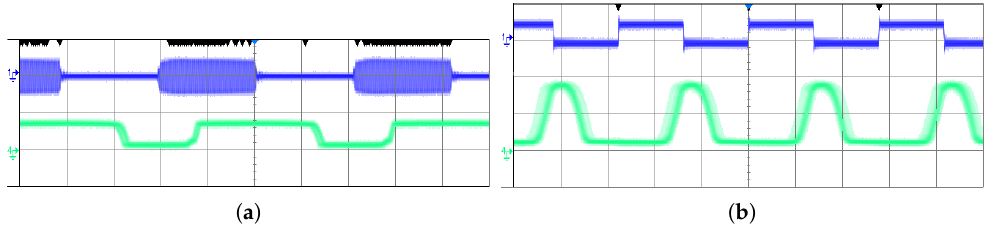
Figure 13. Signal waveforms during square wave communication. ( a ) Master-to-slave communication at 120 kHz. The top signal is the modulated carrier sent by the master. The bottom signal is the demodulated signal output by the slave. The vertical scale is 5 V/div. ( b ) Slave to master communication at 180 kHz. The top signal is the data stream presented to the input of the slave. The bottom signal is the demodulated signal output by the master. The vertical scale is 2